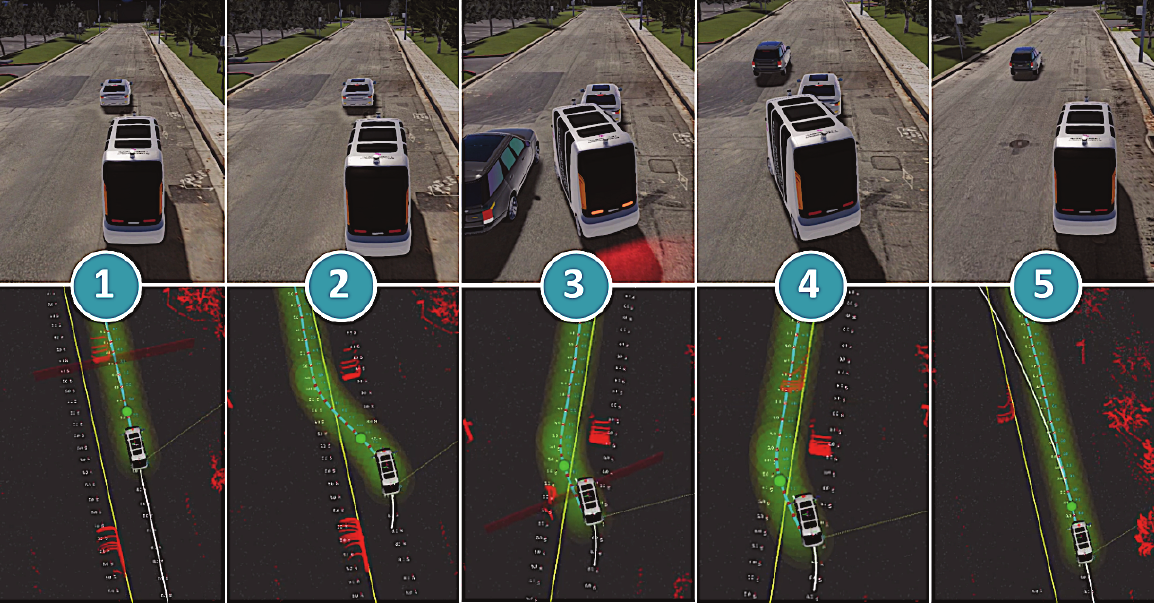
Fig. 10. Different steps of an overtaking